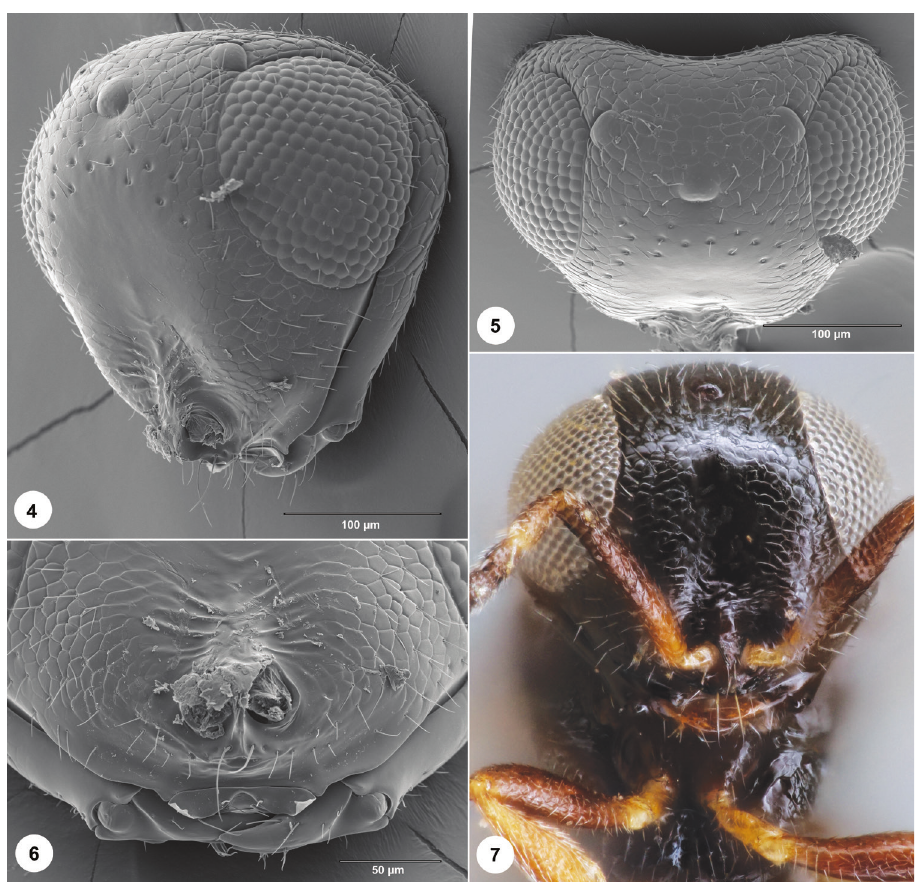
Figures 4–7. Telenomus fariai 4 female (FSCA 00091199), head, anterolateral view 5 female (FSCA 00091199), head, dorsal view 6 female (FSCA 00091199), ventral frons, anterior view 7 female (USN- MENT01795654), head and mesosoma, anterior contiguous with compound eye. Ocellar setae: absent. Sculpture of vertex: shallowly and evenly coriaceous. Shape of vertex: rounded, without hyperoccipital carina. Oc- cipital carina: complete, extending to base of mandibles ventrally, continuous dorsally. Anterior margin of occipital carina: weakly crenulate dorsally, smooth laterally and ventrally. Sculpture of gena: shallowly and evenly coriaceous. Mesosoma. Epomial carina: absent. Sculpture of lateral pronotum: coriaceous microsculpture anterior to netrion. Netrion sulcus: present, weakly defined medially. Sculpture of netrion: smooth. Setation of mesoscutum: evenly covered with white setae throughout. Sculpture of mesoscutum: scaly reticulate microsculpture. Mesoscutal su- prahumeral sulcus: absent. Mesoscutal humeral sulcus: present as a smooth furrow. In- terior of axillar crescent: smooth. Setation of mesoscutellum: evenly covered with white setae throughout. Sculpture of mesoscutellar disc: smooth. Posterior mesoscutellar sul-